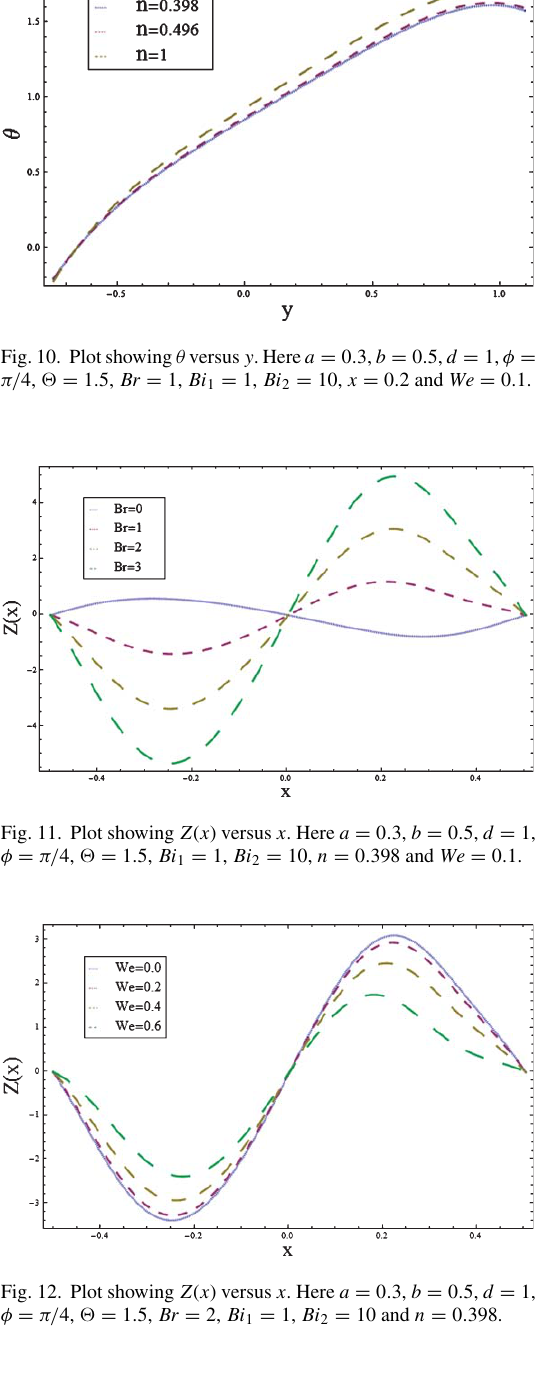
= 1, Bi = 10 and n = 0 . 1 2